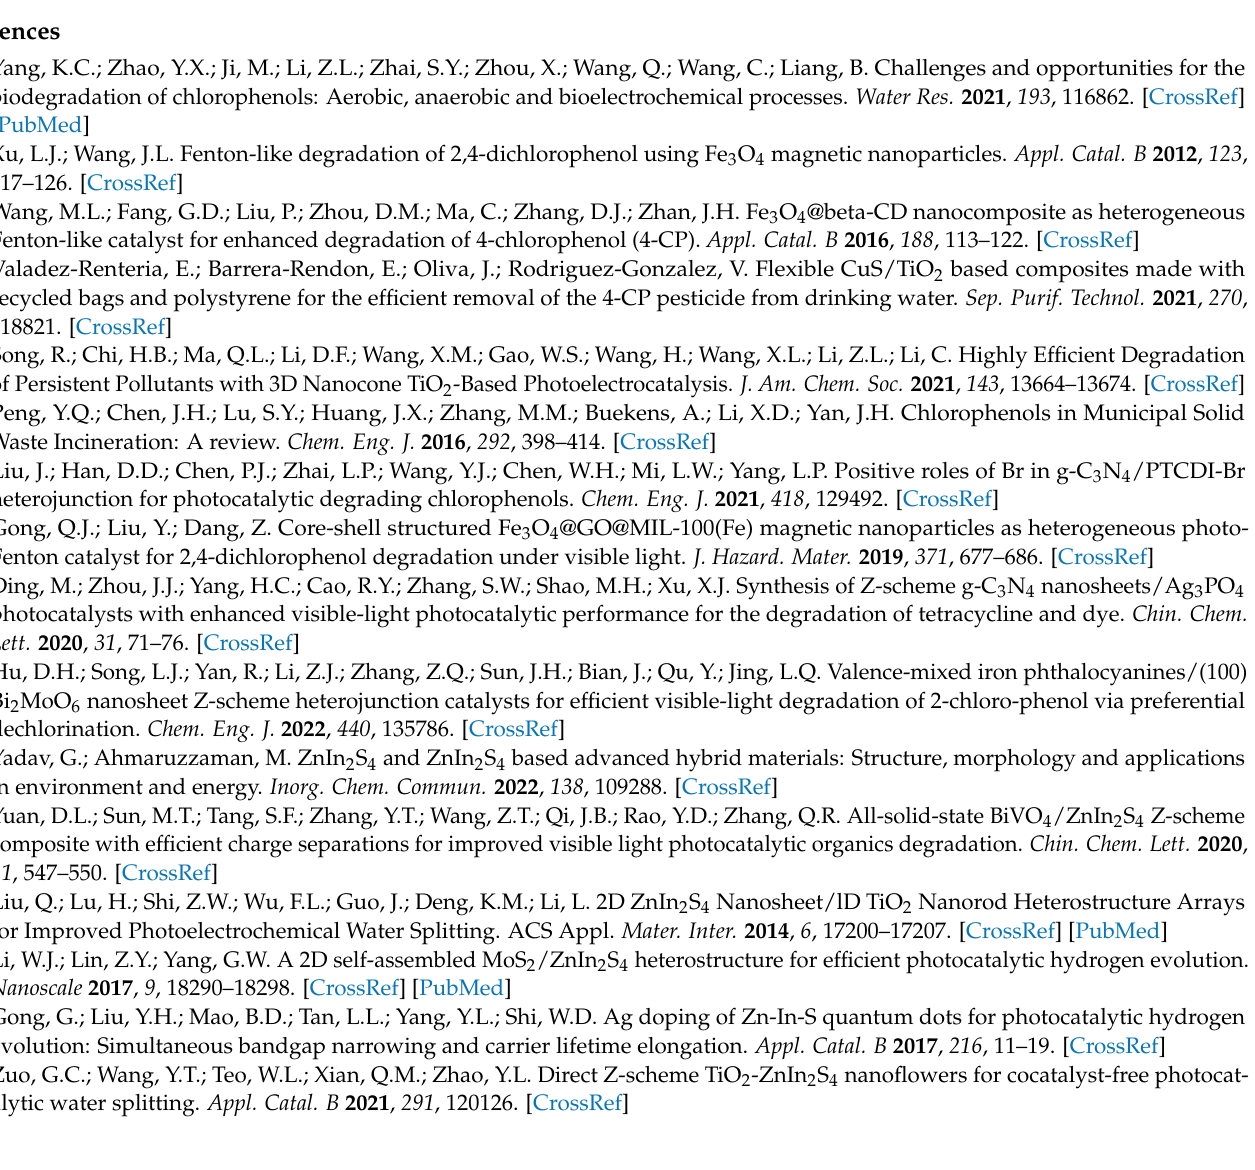
(c) and TEMPO-h + (b) under Xe lamp irradiation.; Figure S11: Cl - concentration of 4-CP; Figure S12: The band gap of ZnIn 2 S 4 ; Figure S13: Mott-Schottky plot of ZnIn 2 S 4 ; Table S1: Comparison of 4-CP